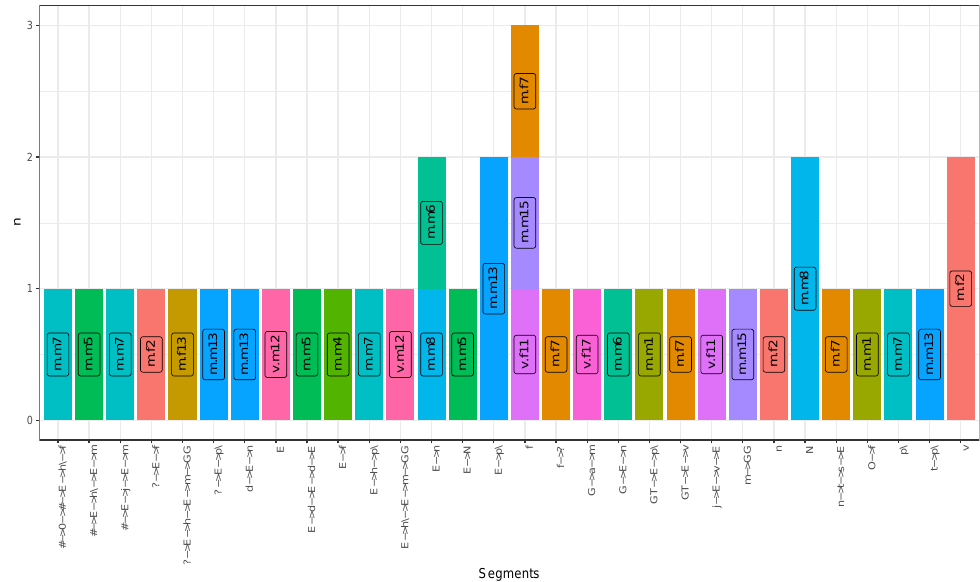
Figure 14. Non-prototypical segments of the vocalic ( fv ) form per sequence and speaker given in SAMPA (p\ = [F] , h\ = [H] ; for other symbols, cf. Table